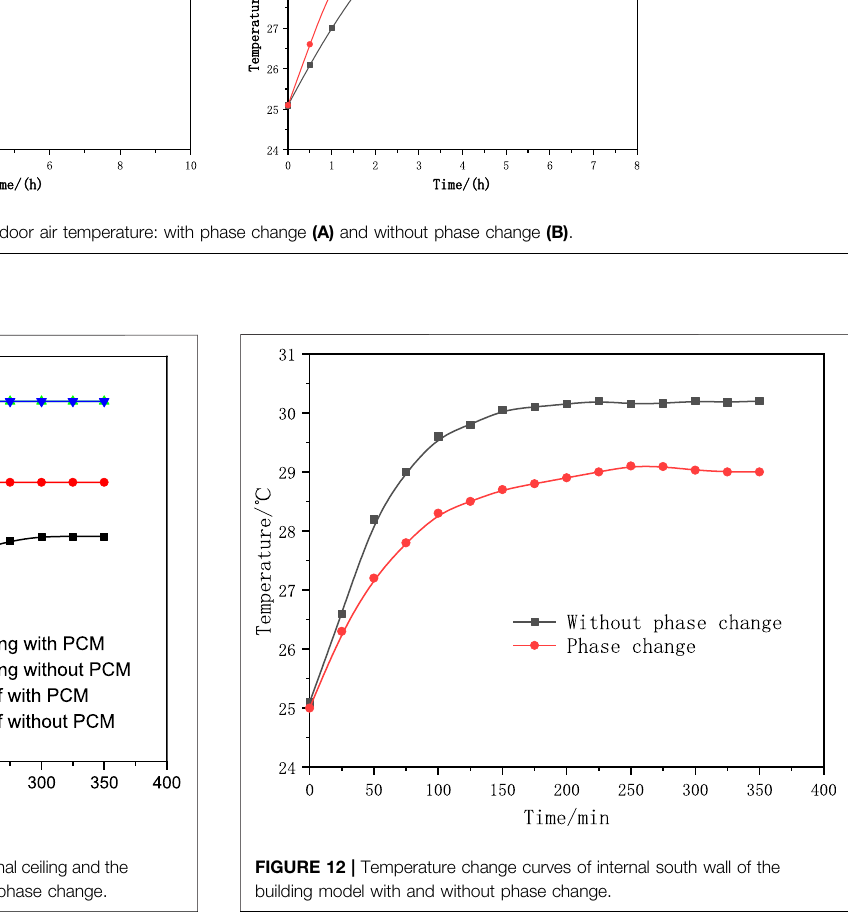
Figure 11 is the temperature change curves of the internal ceiling and external roof of the building models with and without phase change materials. The comparison found that the curve of each acquisition point of the external roof of the PCM model and